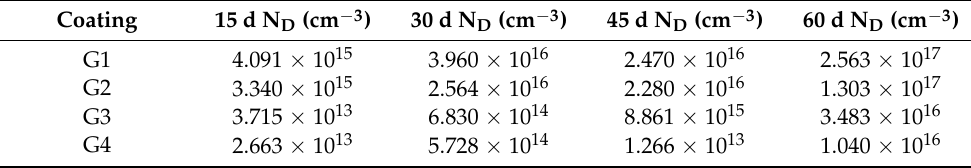
Table 5. Each coating’s carrier density for 15 d, 30 d, 45 d, 60 d in 60%